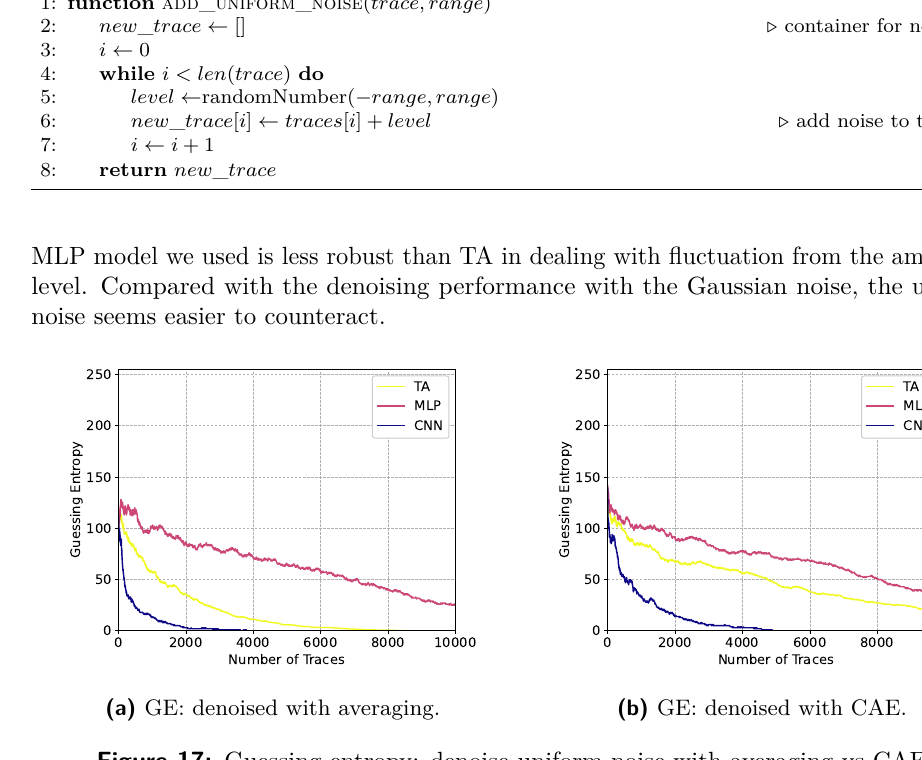
Figure 17: Guessing entropy: denoise uniform noise with averaging vs